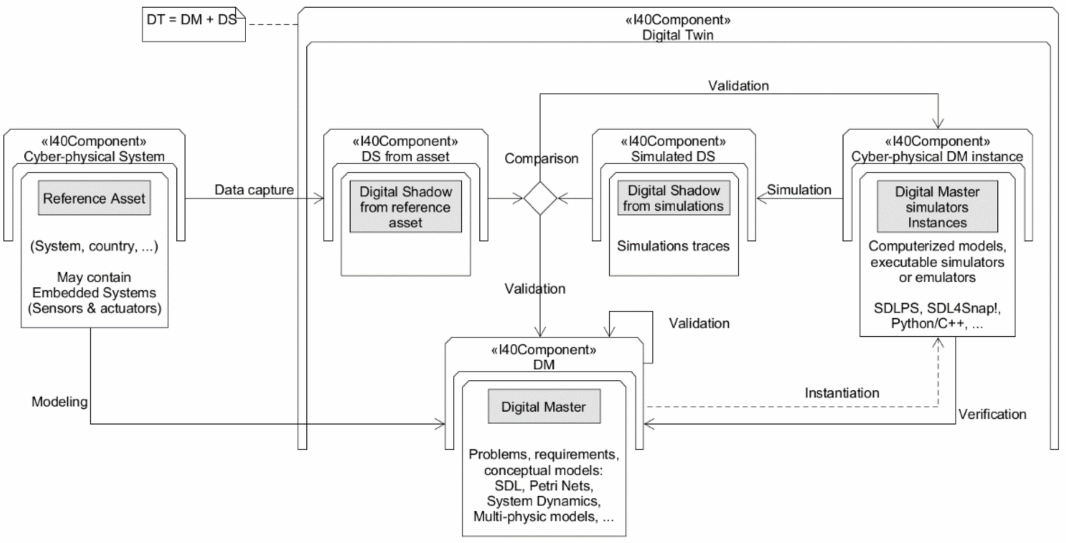
Figure 1. Digital Twin and the V&V